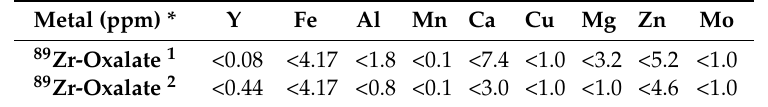
Table 4. Inductively coupled plasma mass spectroscopy (ICP-MS) analysis of the decayed 89 Zr-Oxalate fraction 2 samples from 89 Y-Foil and 89 Y-pressed powder ( n =